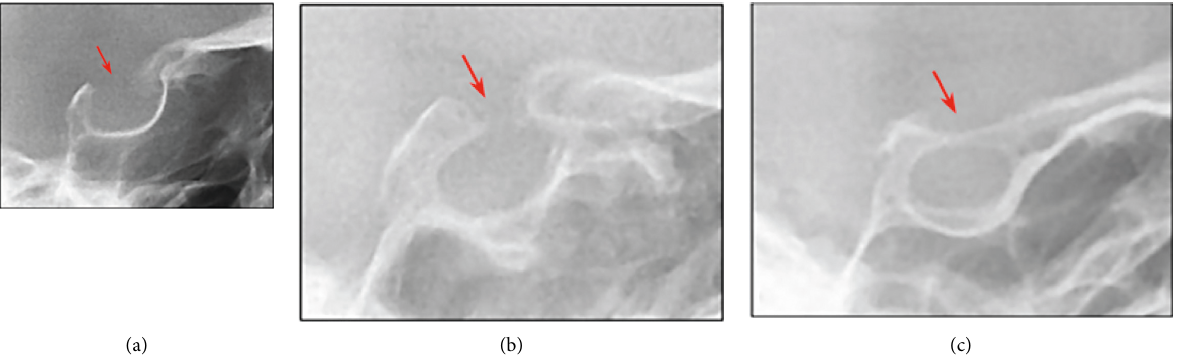
Figure 2: The classification of STB: (a) type I, (b) type II, and (c) type III.